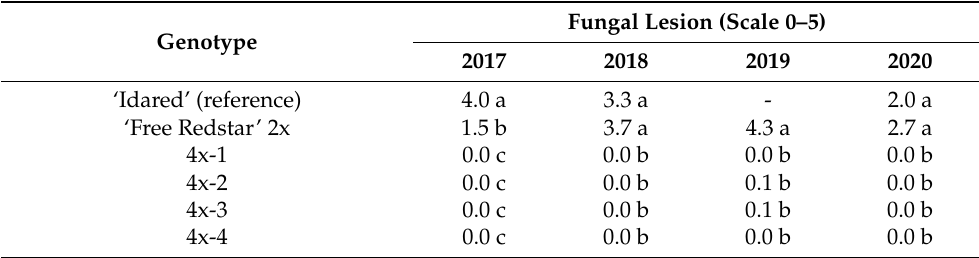
Table 2. Rate of Venturia inaequalis infection of apple tetraploid ‘Free Redstar’ leaves in relation to their diploid counterpart (2x) and to the reference cultivar ‘Idared’ in a greenhouse trial. Fungal lesion was assessed using a six-point scale, in which 0 was 0%, 1 was 0.5%, 2 was 3.0%, 3 was 12.5%, 4 was 35.0%, and 5 was 75.0% of the leaf area affected by the fungus. Fungal Lesion (Scale Genotype